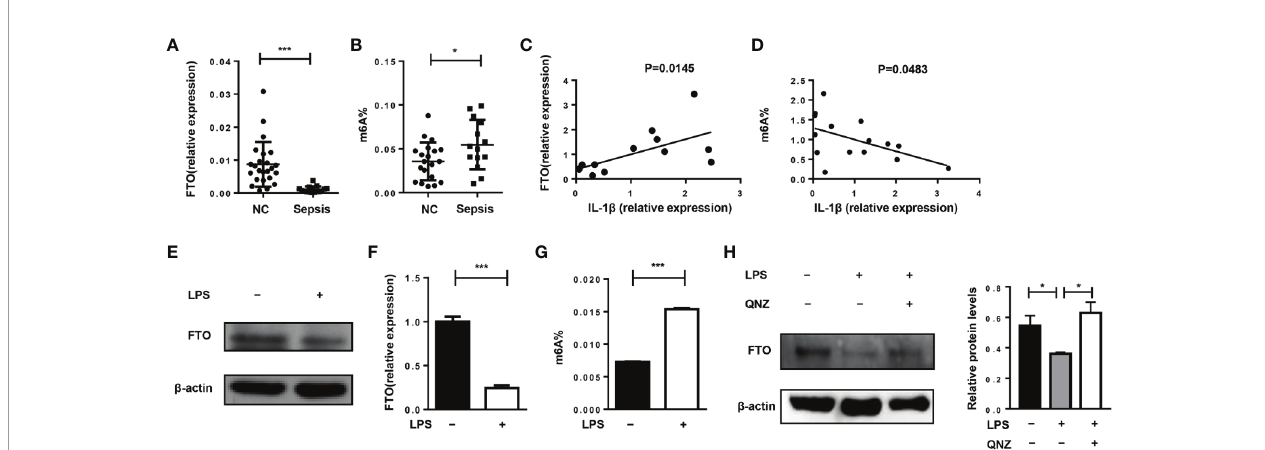
FIGURE 1 | FTO expression is correlated with IL-1 b expression in monocytes of septic shock patients. (A, B) qPCR analysis of expression of FTO and the m 6 A level in peripheral monocytes of septic patients (n = 15) and healthy volunteers (n = 24). (C) Correlation between FTO gene expression (n = 12) and m 6 A level (n = 15) (D) in peripheral monocytes from human patients. Murine BMDMs were treated or untreated with 500 ng/ml LPS. FTO expression was analyzed by western blot (E) and qPCR (F) . (G) The m 6 A level was measured by colorimetric ELISA assay. (H) LPS-stimulated BMDMs were pretreated with or without 5 m M QNZ(EVP4593) prior to the LPS treatment. FTO expression was measured by western blot. b -actin was used as the loading control. Data are shown as mean ± SEM; *P < 0.05; ***P < 0.001 (two-tailed unpaired t-test). Pearson ’ s correlation analysis was performed in (C, D) .